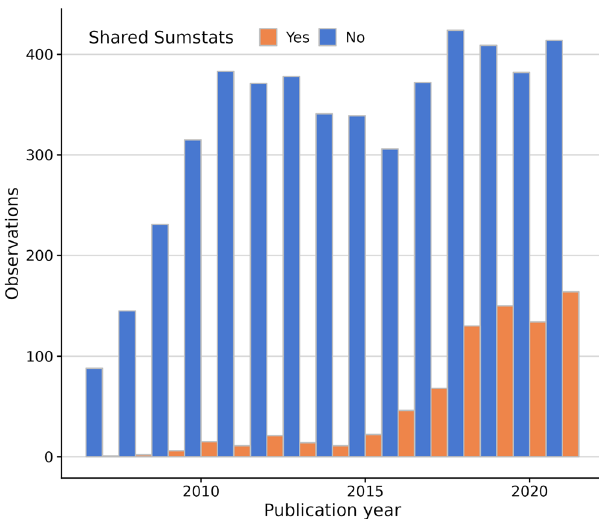
Fig. 1 GWAS summary statistics sharing patterns by year (2007 –